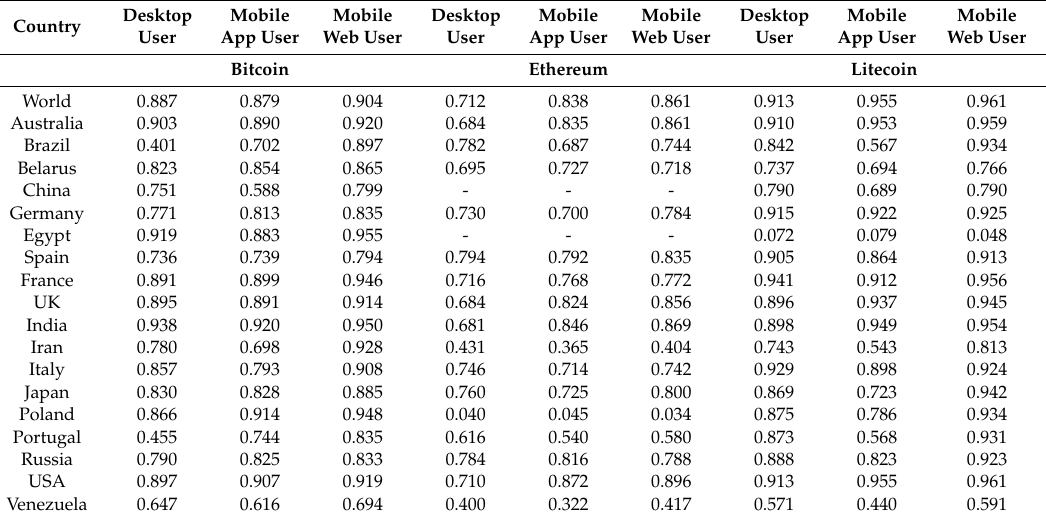
Table 8. Correlations between other user types of Wikipedia visits and Google Trends weekly data.